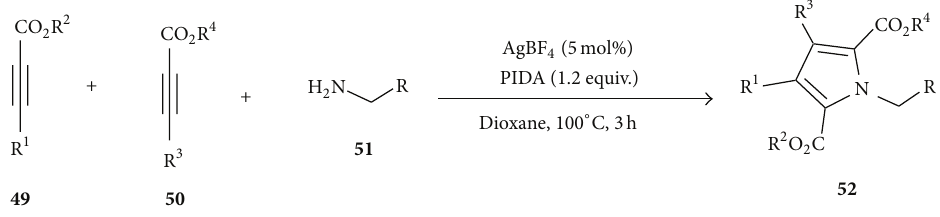
Scheme 8: Synthesis of polysubstituted pyrroles from various alkynoates and